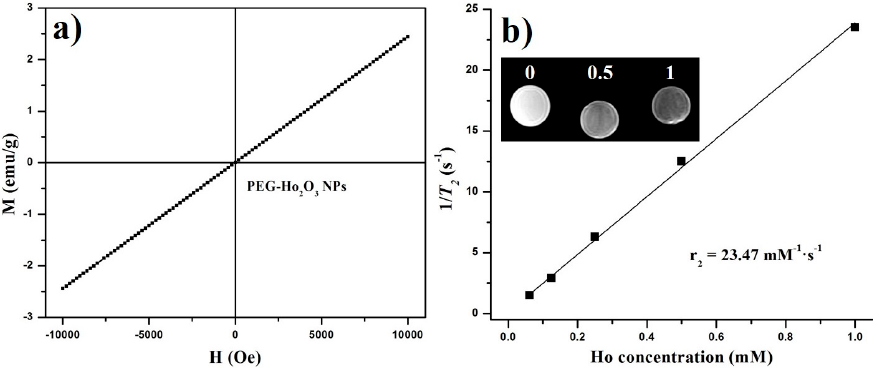
Figure 4. ( a ) Measured M(H) curve at 300 K; ( b ) r 2 relaxation rate (1/ T 2 ) vs. Ho 3+ concentration (mM). Inset is r 2 map images of PEG–Ho 2 O 3 NPs aqueous solution at different concentrations.